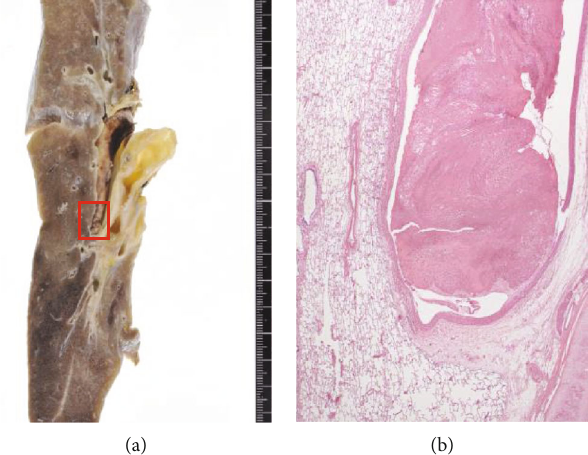
Figure 5: Both iliac veins were fi lled with organized